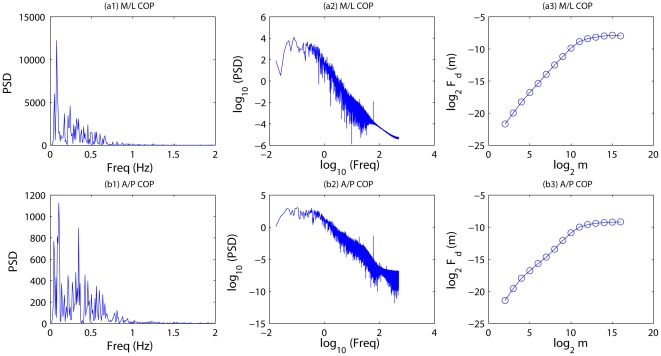
Same as
Fig. 3
 except for day 10.